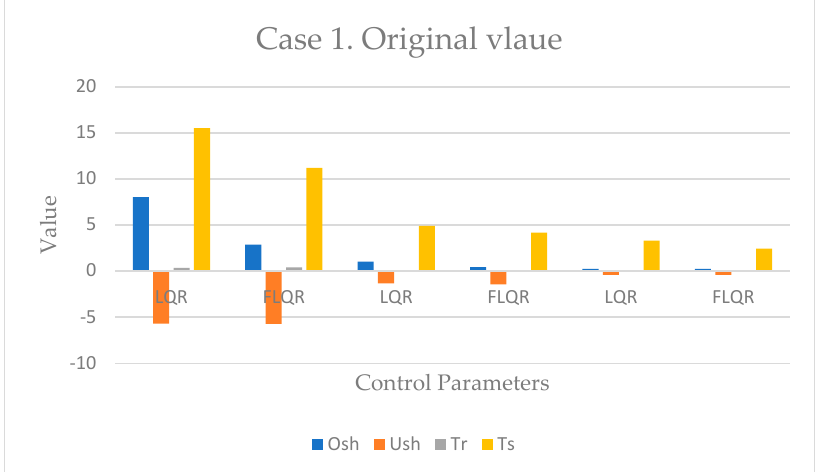
Figure 8. Case 1 comparison.